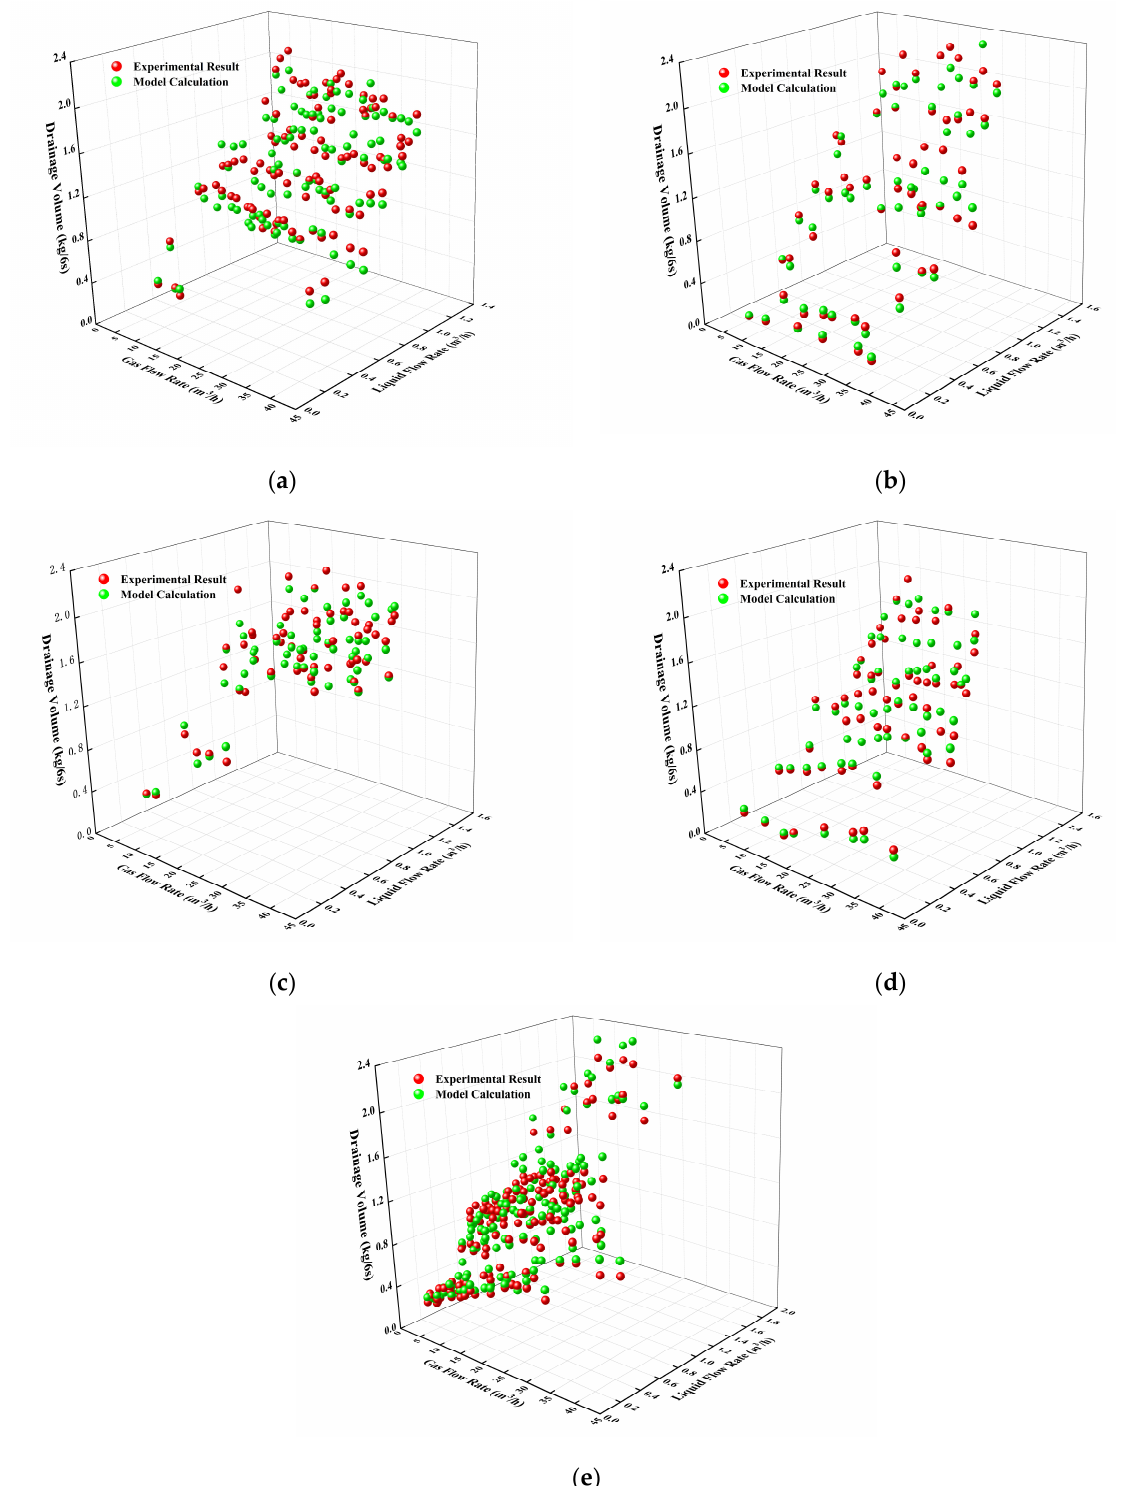
Figure 9. Comparison of model calculation and experimental result: ( a ) upper part of the inclined section; ( b ) heel of the horizontal section; ( c ) 1/3 of the horizontal section; ( d ) 2/3 of the horizontal section; ( e ) toe of the horizontal section.